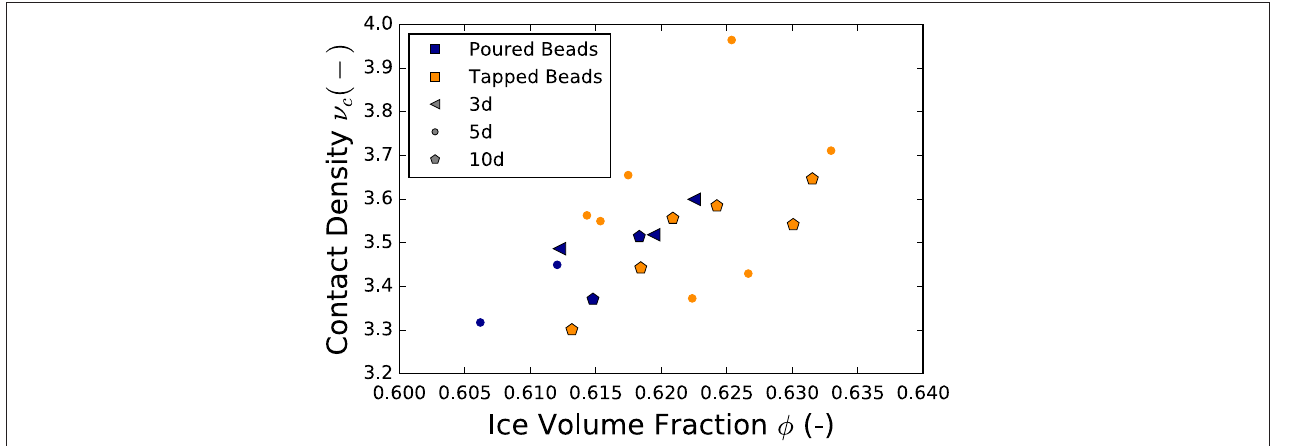
FIGURE 6 | The distinctiveness of poured and tapped samples in the contact density against the ice volume fraction: the tapped samples have by tendency higher densities and more contacts, but also more variability. The sintering time is indicated in the symbols.